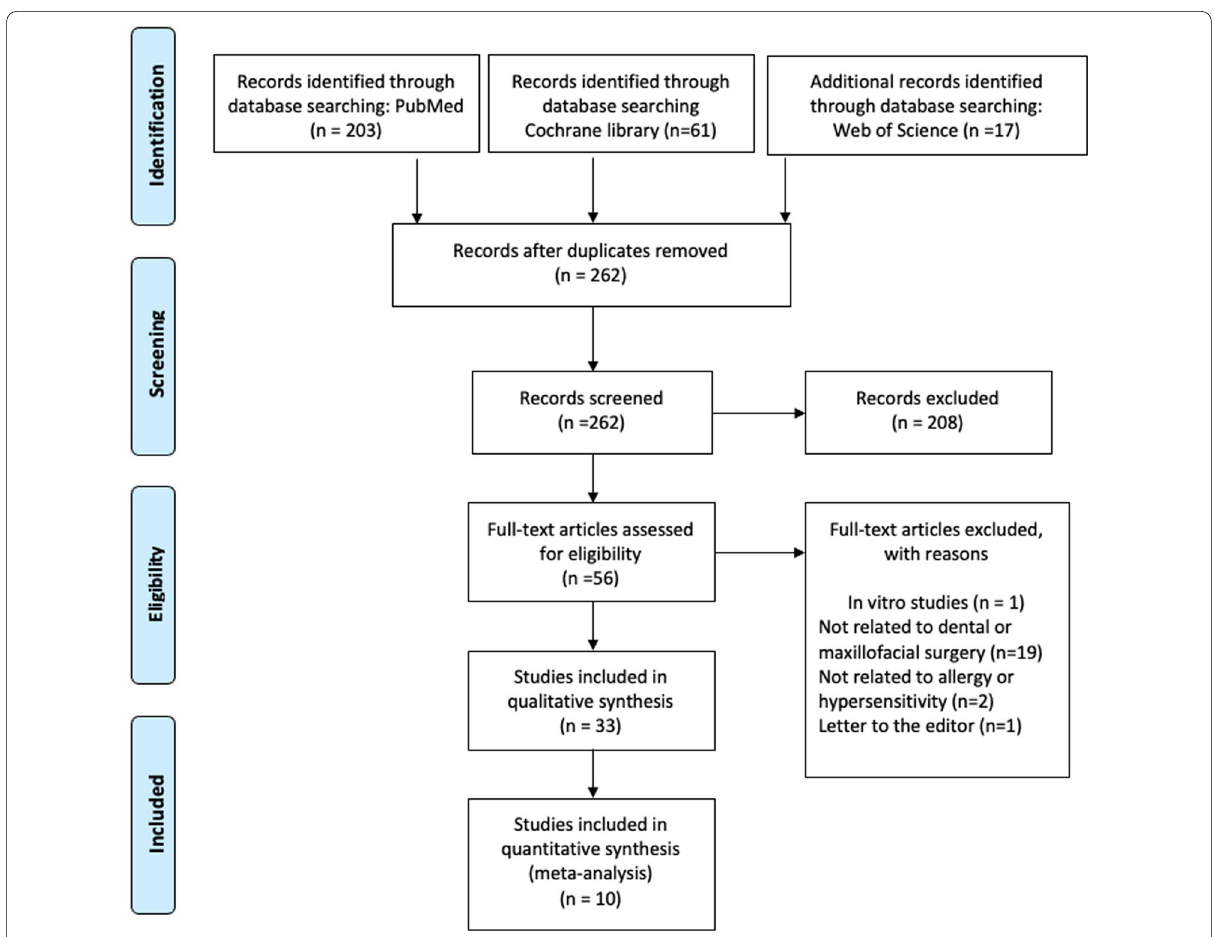
Fig. 2 PRISMA flow diagram